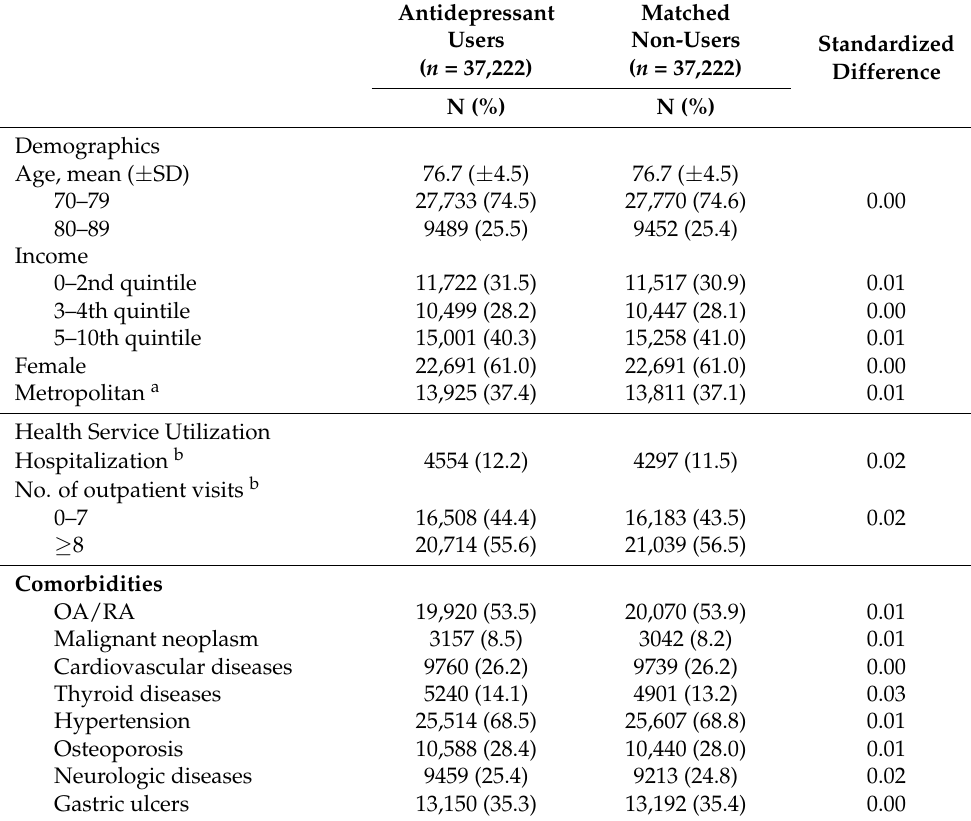
Table 1. The baseline characteristics of the antidepressant users and the matched non-users.